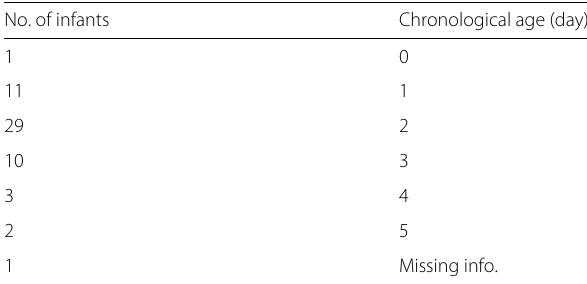
Table 1 The chronological ages of infant subjects in the